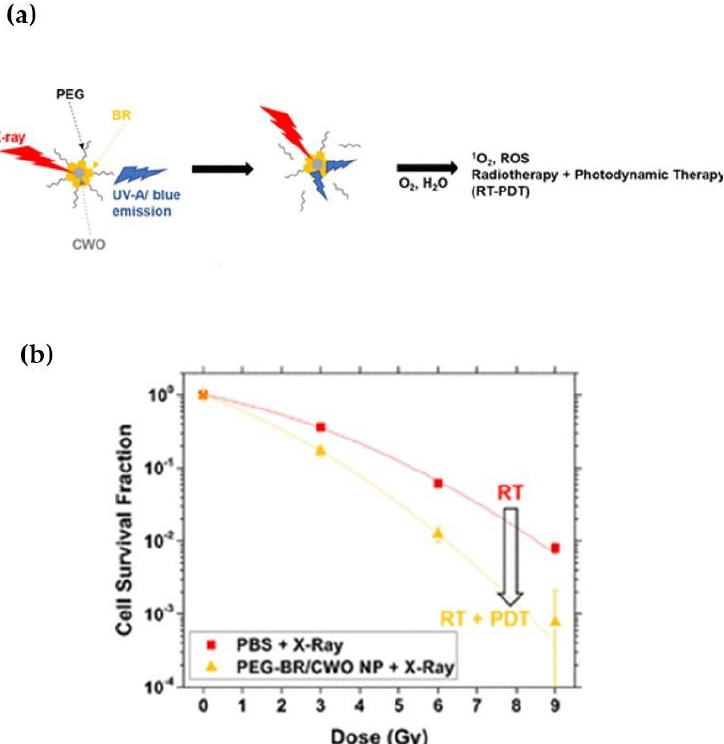
Figure 2. ( a ) Schematic image of the PEG-BR/CWO NP mechanism of action. ( b ) PEG-BR/CWO NP initial clonogenic survival assay. HN31 cells were plated in 6-well plates at 0.2 × 103 (0 Gy), 0.8 × 103 (3 Gy), 1.6 × 103 (6 Gy) and 5.0 × 103 (9 Gy) in triplicate for each treatment group. Cells were incubated with PBS, PEG-BR micelles (0.2 mg/mL PEG-BR) and PEG-BR/CWO NPs (0.2 mg/mL CWO nanoparticle) for 4 h prior to radiotherapy. Irradiation was performed with a 320 kV X-ray irradiator (2 Gy/min). Reprinted with permission from Ref. [62] . Copyright 2020, American Chemical Society.